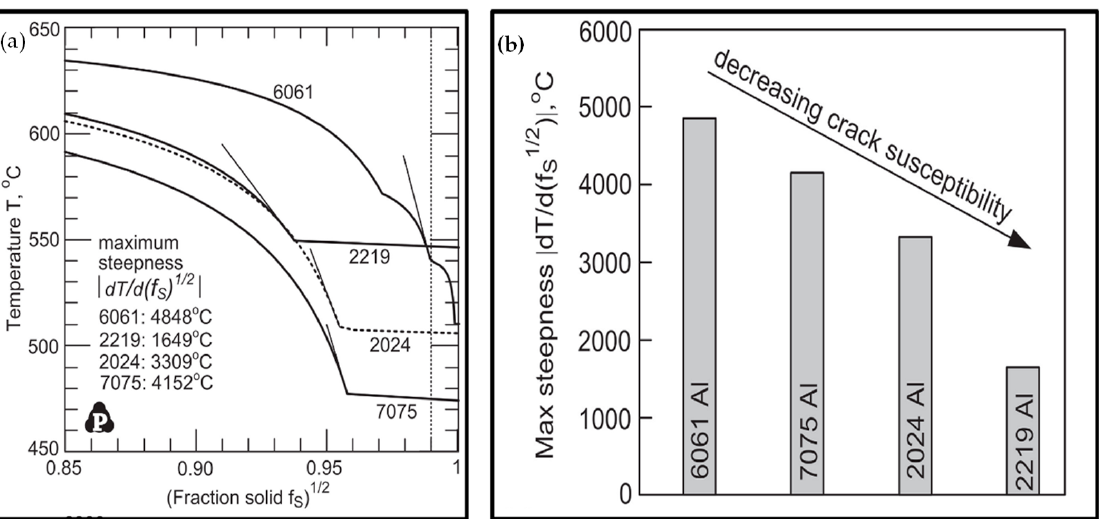
Figure 5. Crack susceptibility of HS ‐ Al alloys: ( a ) T ‐ ( fs ) 1/2 curve showing maximum steepness; ( b ) steepness variations of different Al alloys. Reproduced with permission from Elsevier [108].